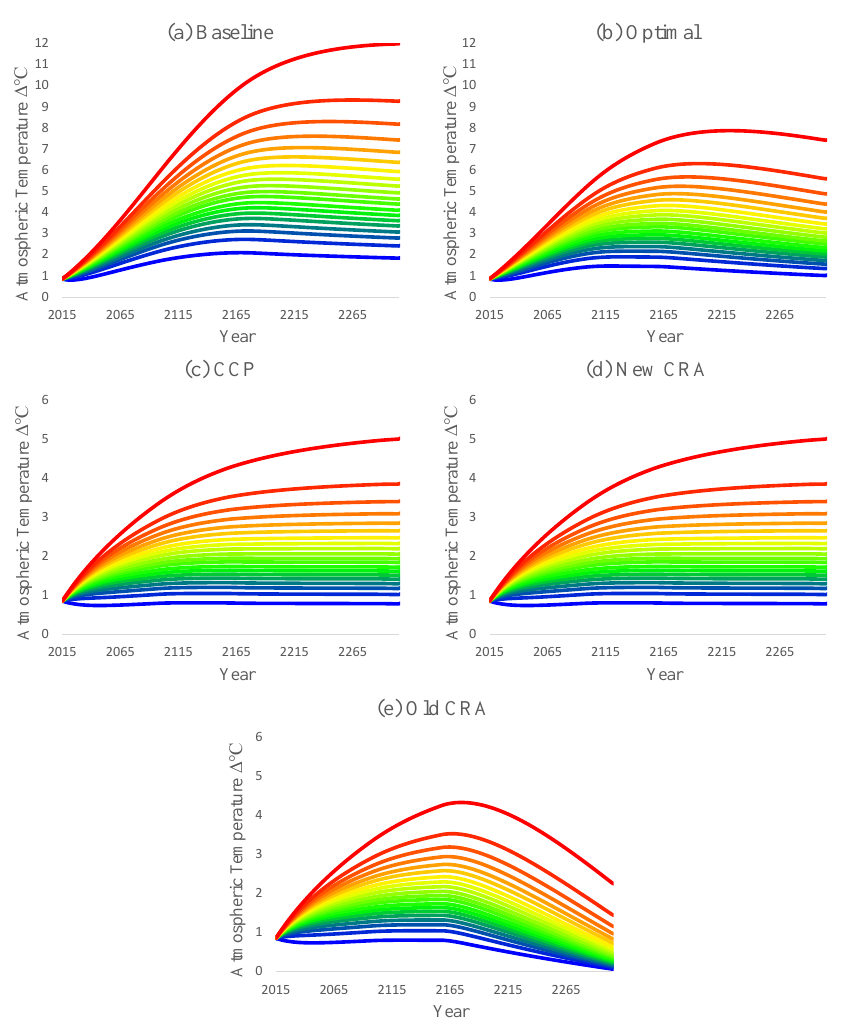
Figure 2. Atmospheric temperature evolution under the baseline, optimal, CCP, New CRA, and Old CRA scenarios. The colors show different states of the worlds ranging from dark blue for the lowest climate sensitivity to dark red for the highest climate sensitivity.